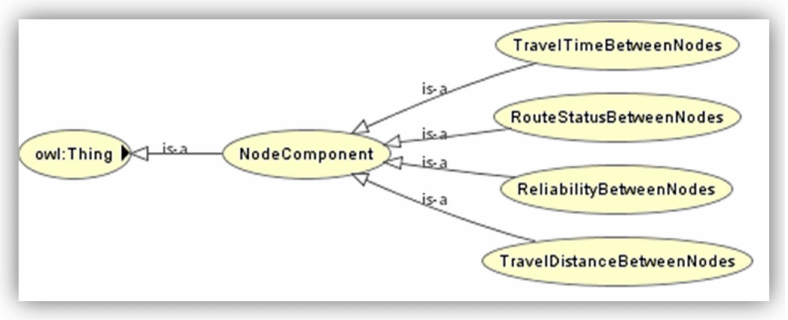
Figure 5. The NodeComponent class.